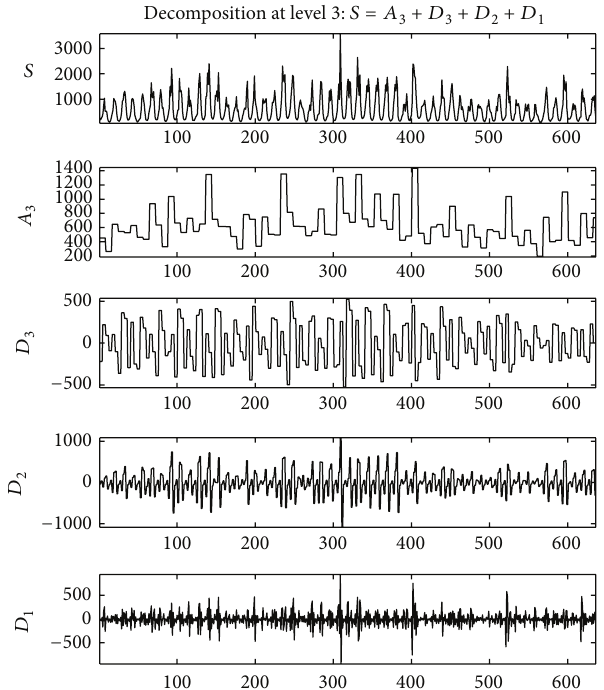
Figure 4: Decomposed wavelet subtime series components ( D s) of runoff data of Tangnaihai